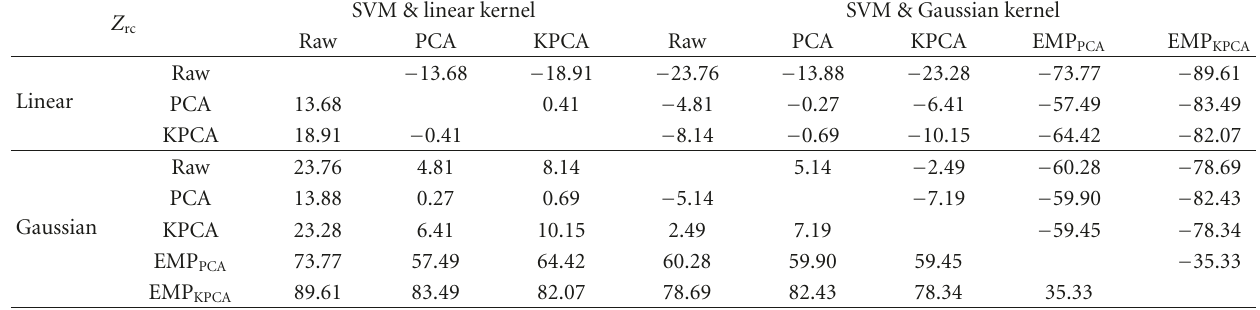
Table 7: Statistical Significance of Di ff erences in Classification ( Z ) for the University Area data set. Each case of the table represents Z rc where r is the row and c is the column.